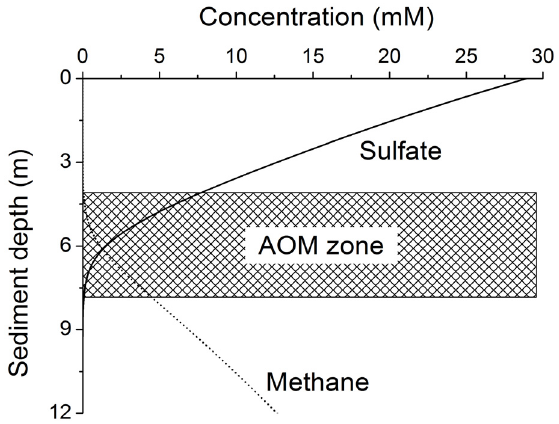
Figure 15. Concentrations of dissolved sulfate (solid line) and dissolved methane (dotted line) in surface sediments calculated in the reference model run. The shaded bar indicates the sediment layer where methane is oxidized by microbial consortia using sulfate as terminal electron acceptor (AOM zone). The AOM zone is equivalent to the sulfate-methane transition zone (SMTZ).